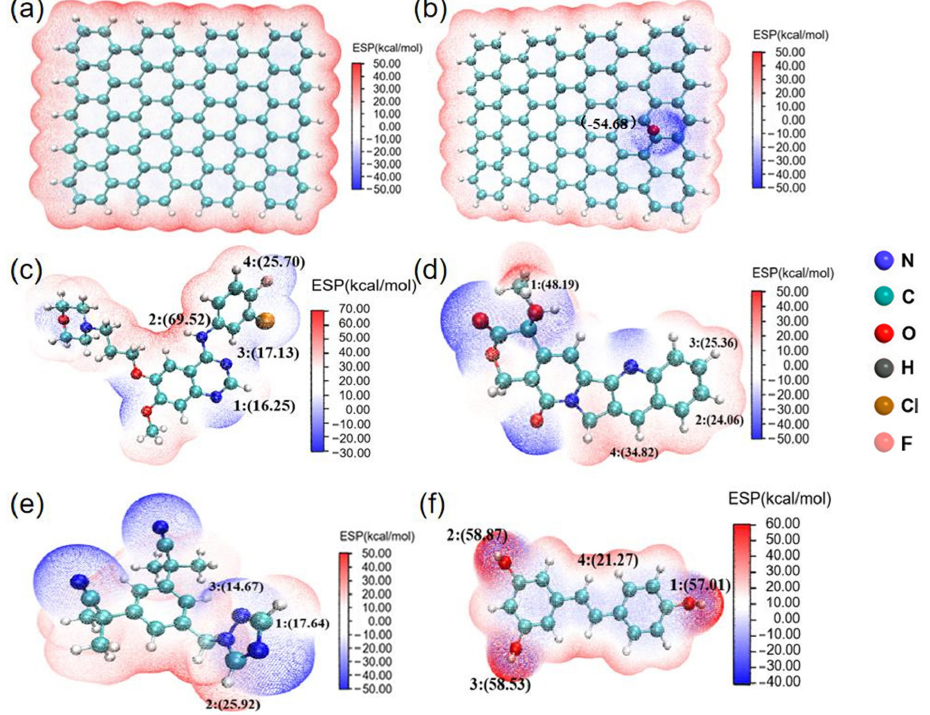
Figure 1. The electrostatic potential (ESP) distribution of ( a ) RGO; ( b ) GO; ( c ) Gefi; ( d ) CPT; ( e ) Anas; ( f ) Res.